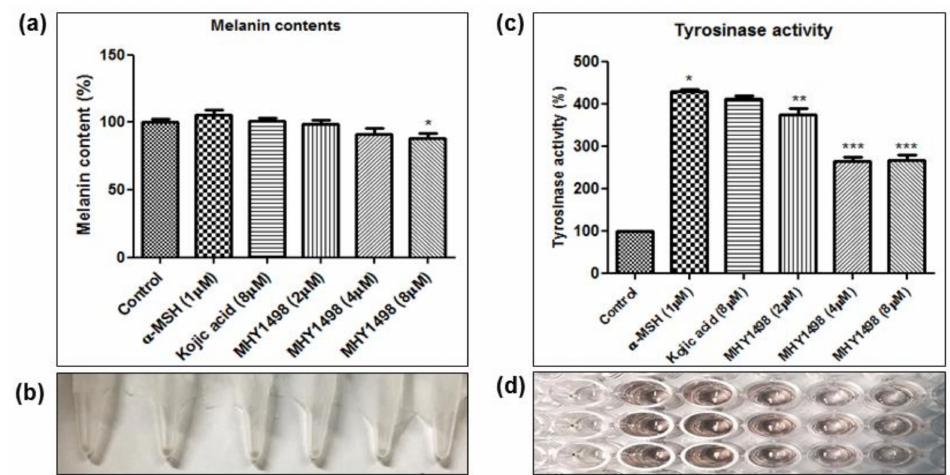
Figure 6. Effects of MHY1498 on melanin synthesis in B16F10 melanoma cells. ( a ) B16F10 cells were incubated with 2, 4 or 8 µ M MHY1498 for 48 h. The melanin content in B16F10 cells was determined as described. The melanin content of control cells was defined as 100%. Kojic acid was used as a positive control. All data are shown as mean ± SD (* p < 0.001, control vs. α -MSH, ** p < 0.05, MHY1498 (2 µ M) vs. α -MSH, *** p < 0.001, MHY1498 (4, 8 µ M) vs. α -MSH). ( b ) Cellular pigmentation in